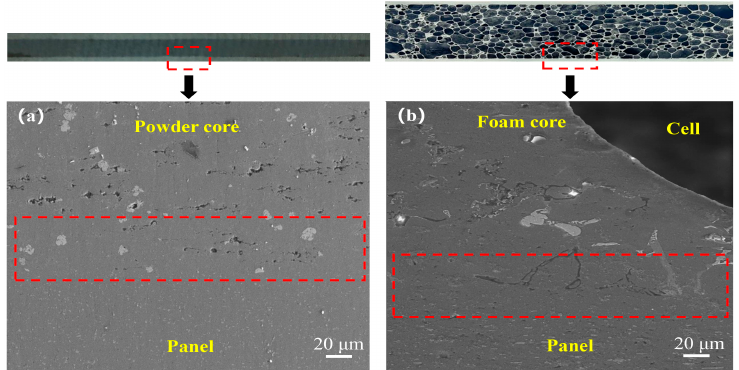
Figure 3. Micro metallurgical interface bonding morphologies: ( a ) Metallurgical bonding interface of the foamable precursor; ( b ) Bonding interface after foaming.